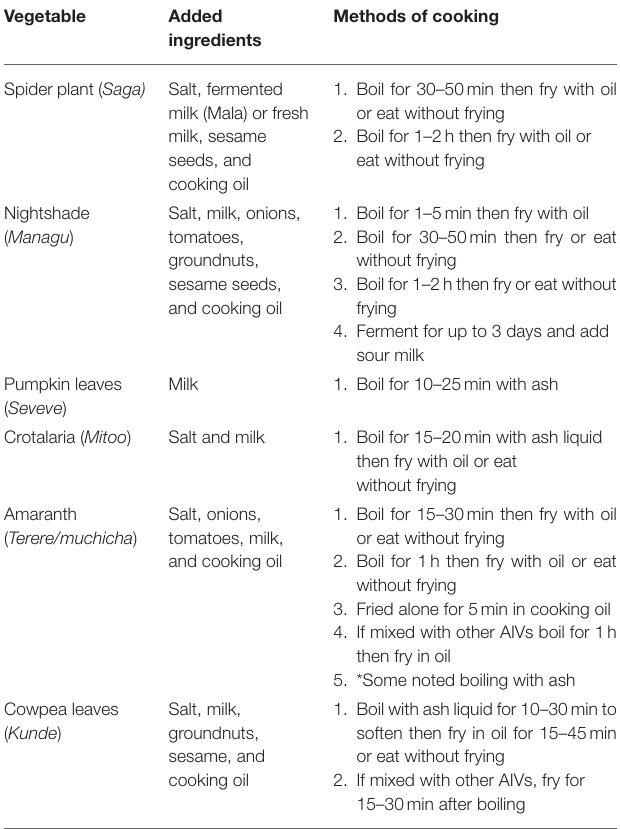
TABLE 3 | Commonly added ingredients and cooking methods for African Indigenous Vegetables. Vegetable Added Methods of ingredients